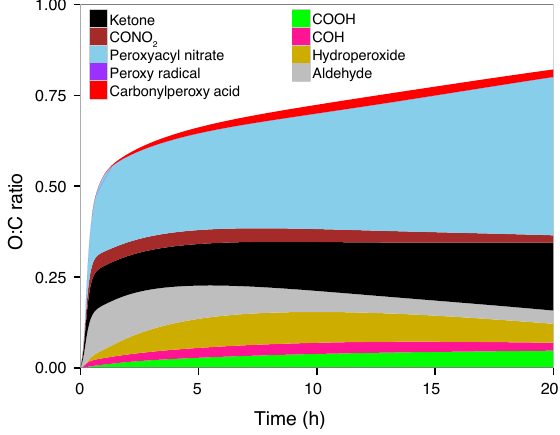
Figure 7. Time series of FG contributions to the total O:C of the gas phase generated by photooxidation of α -pinene in low-NO x regime, simulated using the MCMv3.2 degradation